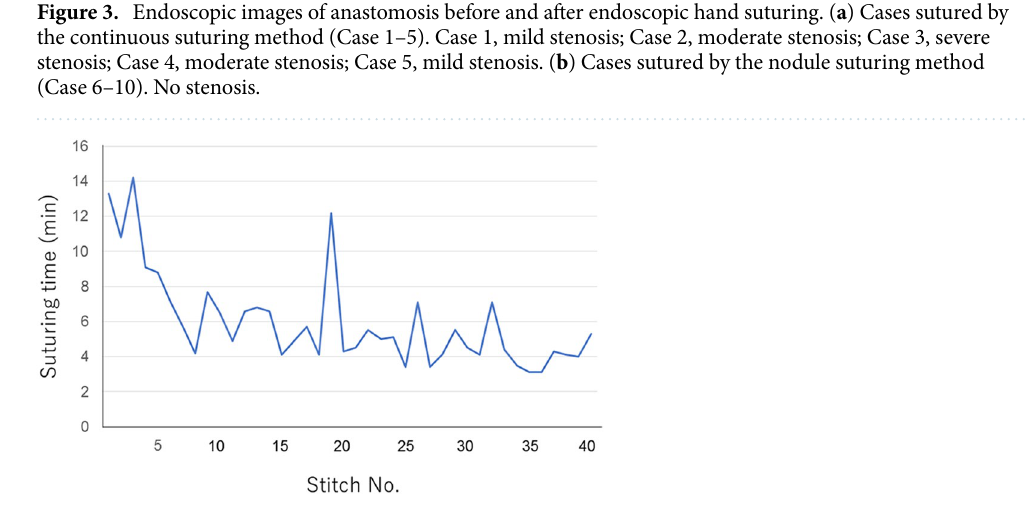
Figure 4. Changes in suturing time in the nodule-suturing method. The suturing time, defined as the duration required for creating a single nodule, becomes shorter as the number of stitches is accumulated.